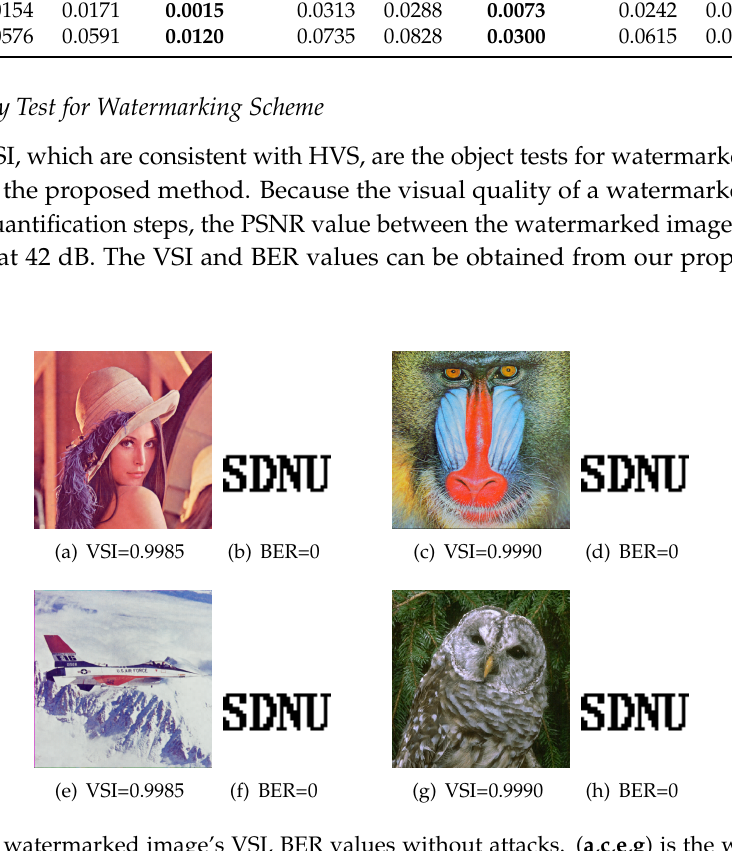
Figure 5. The watermarked image’s VSI, BER values without attacks. ( a , c , e , g ) is the watermarked image with VSI, and ( b , d , f , h ) is extrat water information without